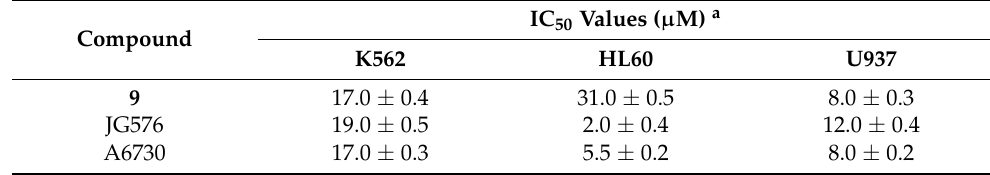
Table 1. In vitro activity of compounds 9 , JG576 and A6730 on K562, HL60 and U937 cells.